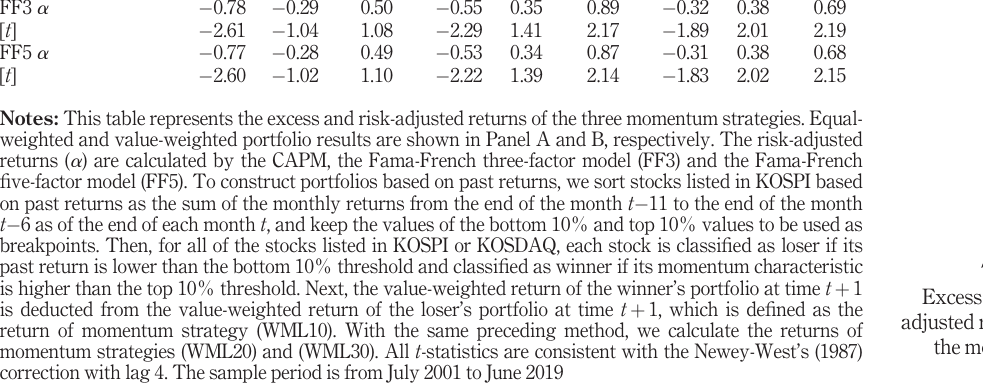
Table 3. Excess and